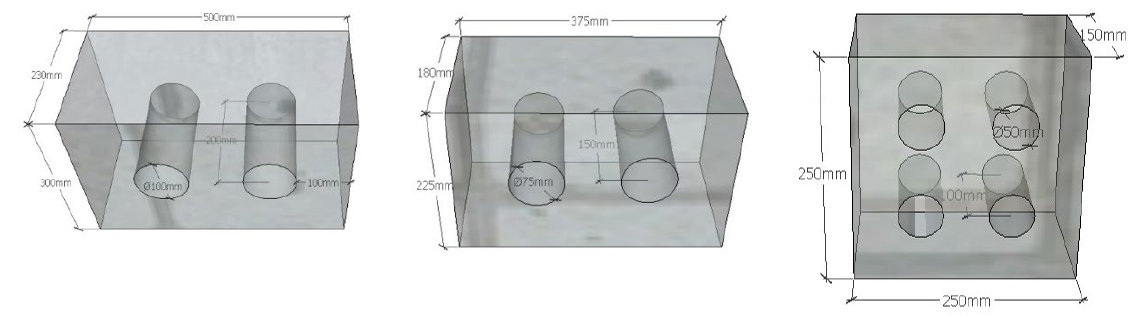
Figure 1 – Drilling hole placement according to block